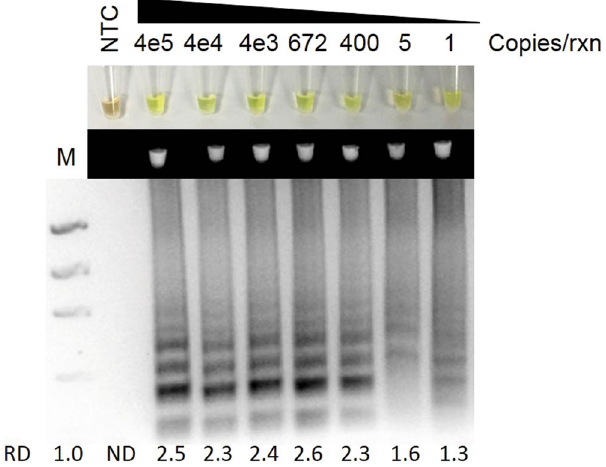
Figure 2. ZIKV RT-LAMP sensitivity for ZIKV. Sensitivity assessment of ZIKV RT-LAMP using serial dilutions of ZIKV PCR Standard (Robert Koch Institute) from 4 × 10 5 genome copies/reaction to 1 copies/ reaction as visualized by addition of SYBR Green I by eye (upper panel), green fluorescence (middle panel), or gel electrophoresis (bottom panel). Lane M: Low DNA Mass Marker (ThermoFisher Scientific); NTC: No template control (negative control). Relative density (RD) of the entire bands for a column relative to the DNA Mass Marker are indicated below the corresponding lane. Lanes that did not have any detectable bands over background are reported as not detectable (ND).